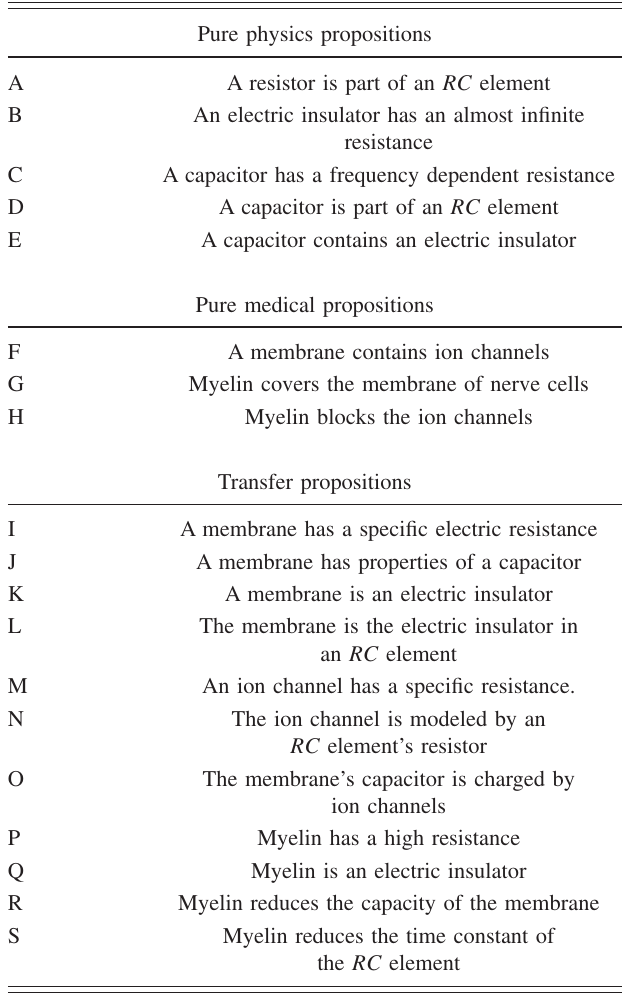
TABLE I. Answers to the expert’s map in Fig. 4.